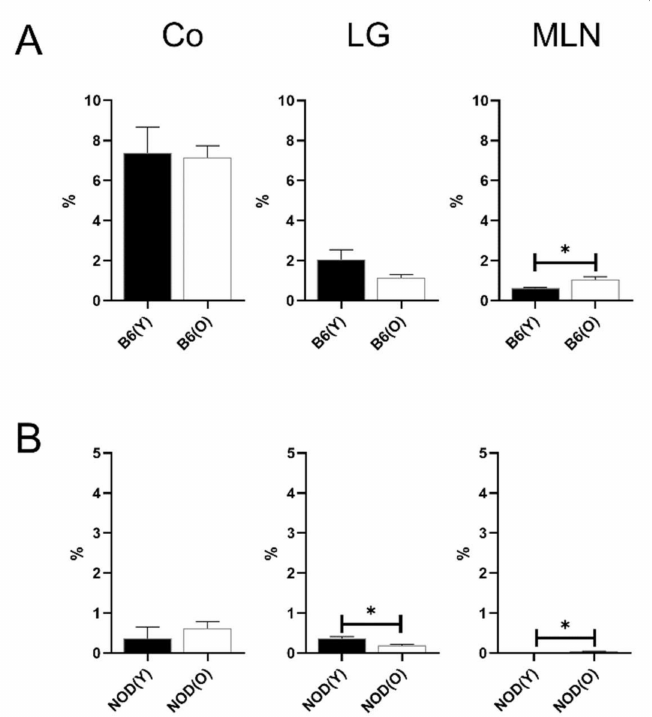
Figure 8. Distribution of neutrophil/eosinophils in B6 ( A ) ( n = 4) and NOD.B10.H2 b ( B ) mice ( n = 4). The total number of CD45 + cells was used as the denominator to compen- sate for the actual fraction of each subset in corneolimbus and LG. In MLN, the percent- age of subsets was calculated as the percentage within total cells. The percentage of neu- trophils/eosinophils (CD45 + CD11b + CD11c − CD24 + MHCII lo ) was significantly higher in aged B6 mice than young B6 mice in MLN ( p = 0.032). The percentage of neutrophils/eosinophils (CD45 + CD11b + CD11c − CD24 + MHCII lo ) of LG was also lower in aged NOD.B10.H2 b mice than in young mice ( p = 0.022). However, MLN showed a considerably increased proportion of neu- trophils/eosinophils in aged NOD.B10.H2b mice ( p = 0.015). All experiment results were tested for statistical differences using unpaired, two-tailed independent t-tests. Data are expressed as the mean ± standard error of the mean. B6, C57BL/6; NOD, NOD.B10.H2 b ; DC, dendritic cell; CO, corneolimbus; LG, lacrimal gland; MLN, mesenteric lymph node; B6(Y), young B6 mice; B6(O),